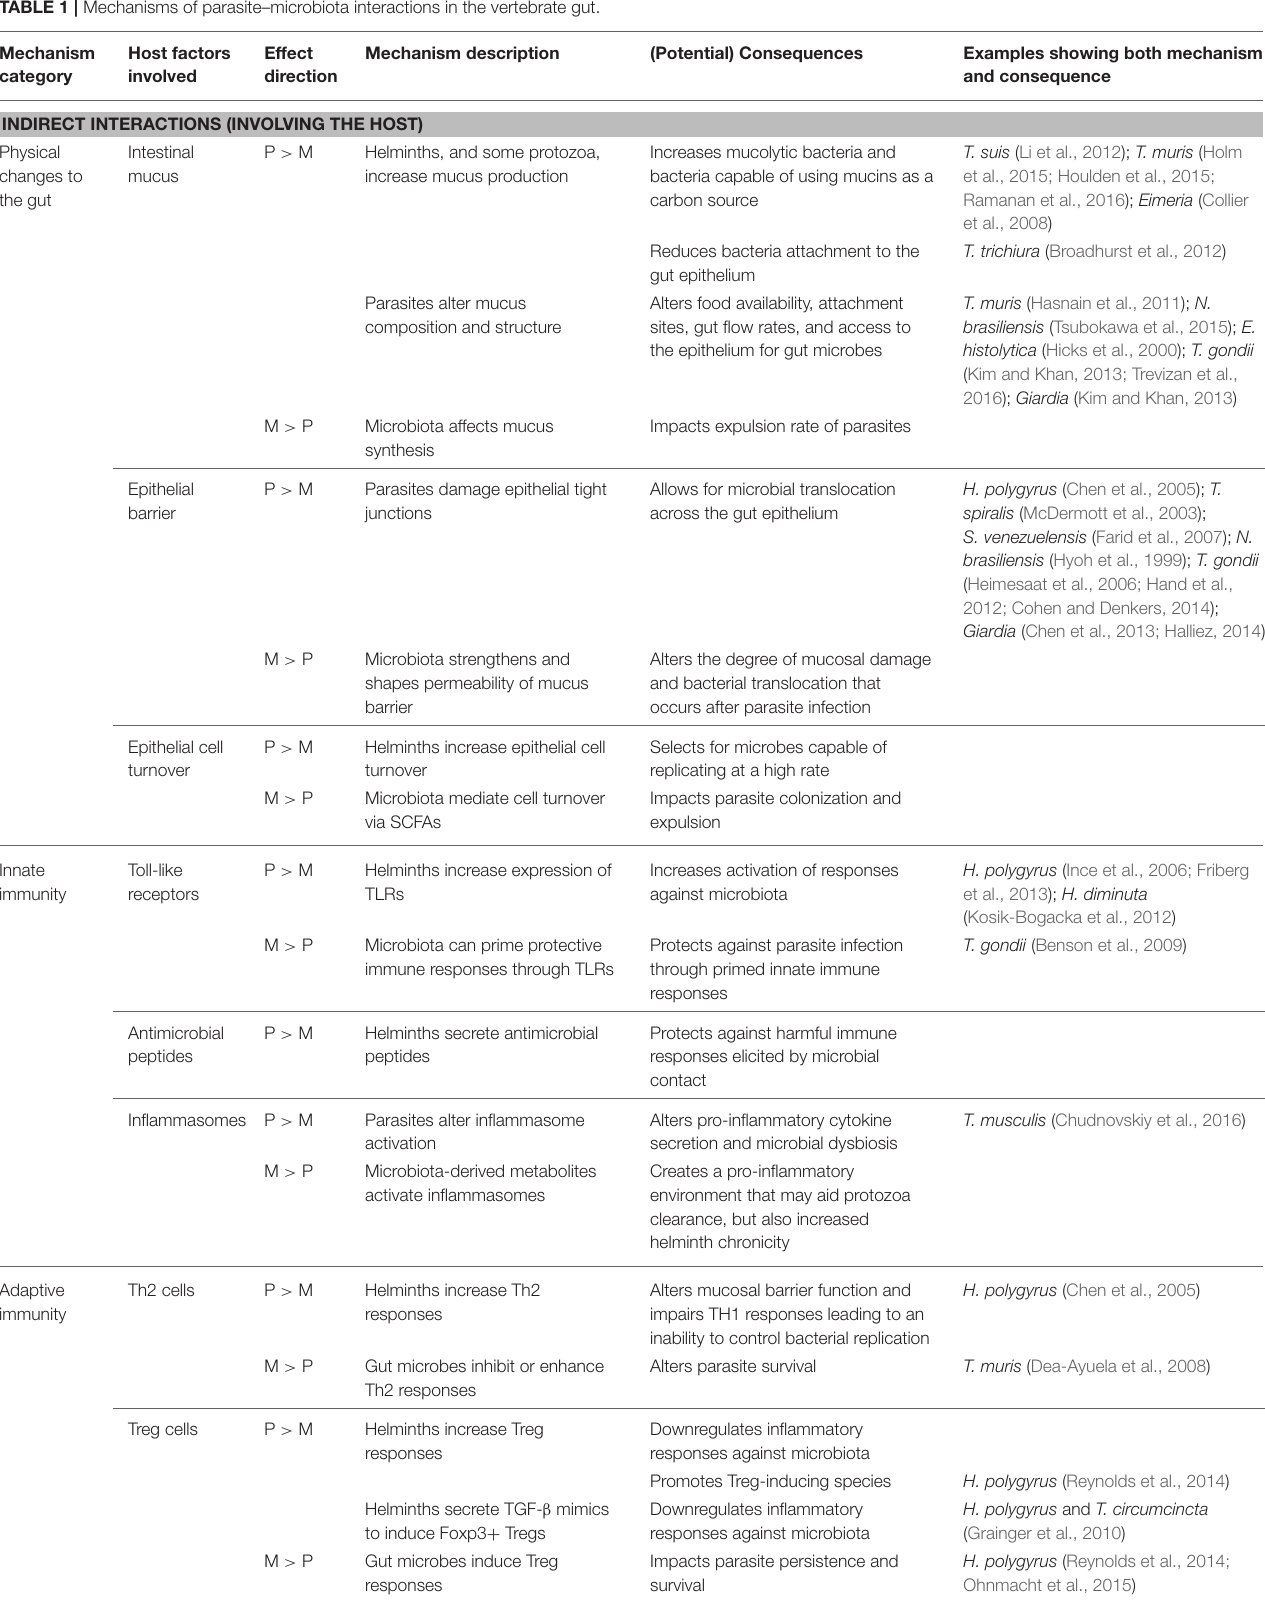
TABLE 1 | Mechanisms of parasite–microbiota interactions in the vertebrate gut. Mechanism